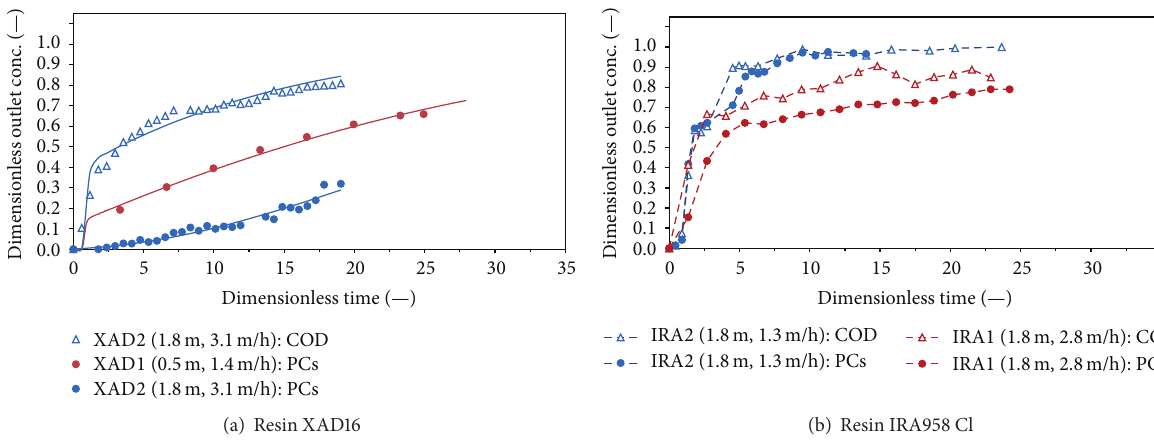
Figure 3: (a) PC and COD breakthrough tests conducted with resin XAD16 in the 0.5 m column (XAD1, 1.4 m/h) and in the 1.8m column (XAD2, 3.1 m/h); the continuous lines indicate the best-fitting simulations performed with (1) and (2); (b) PC and COD breakthrough tests conducted with resin IRA958 Cl in the 1.8m column (IRA1, 2.8 m/h; IRA2, 1.3m/h); no simulations were performed for the IRA tests.